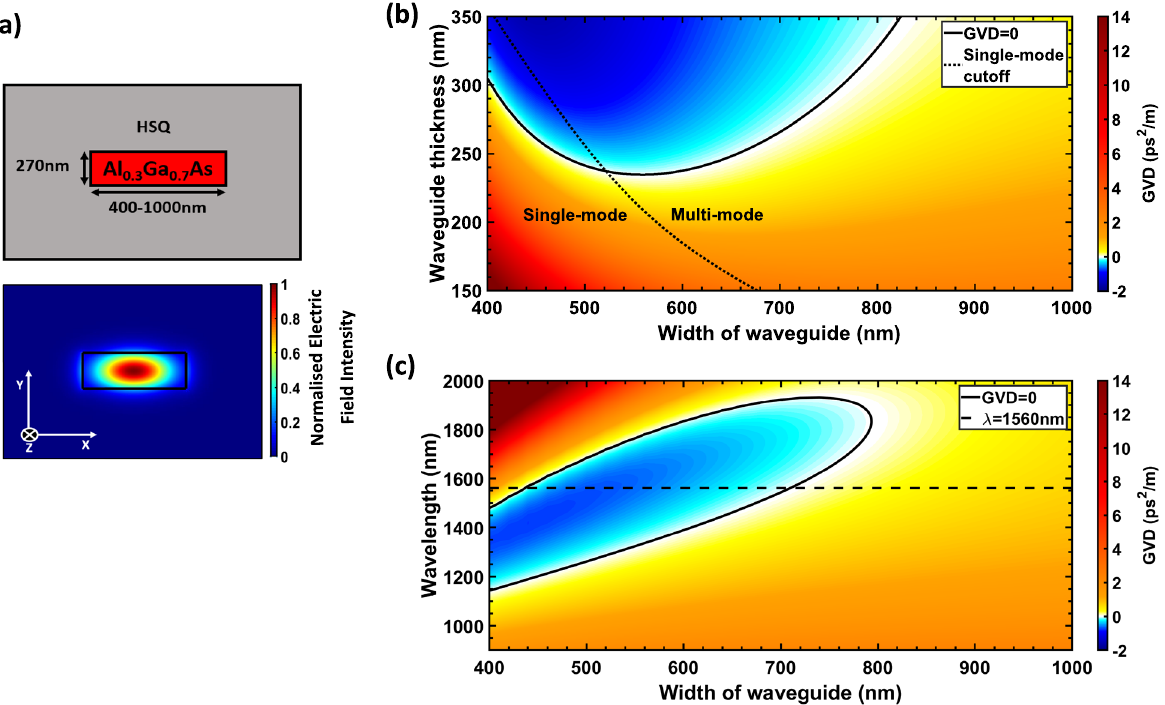
Figure 1. Dispersion engineering of AlGaAs-OI waveguides. ( a ) Diagram of the waveguide cross section and corresponding electric field intensity of the fundamental quasi-TE mode used for SCG, where z is the propagation axis into the page ( (cid:31) = 1560nm ). ( b ) Simulation showing how the group velocity dispersion, GVD, of the fundamental quasi-TE mode at a fixed wavelength of 1560 nm varies with both the width and thickness of the Al 0.3 Ga 0.7 As -OI waveguide. The solid black line highlights the dimensions where the GVD is equal to zero whilst the dashed black line indicates where the waveguide becomes multi-mode i.e. when higher order modes begin to propagate. ( c ) Simulation depicting the GVD against width and wavelength for a fixed waveguide thickness of 270nm. Zero GVD and the pump wavelength at 1560nm are shown with a solid and dashed black lines, respectively. All simulations were conducted using the finite difference eigenmode (FDE) solver from Lumerical,